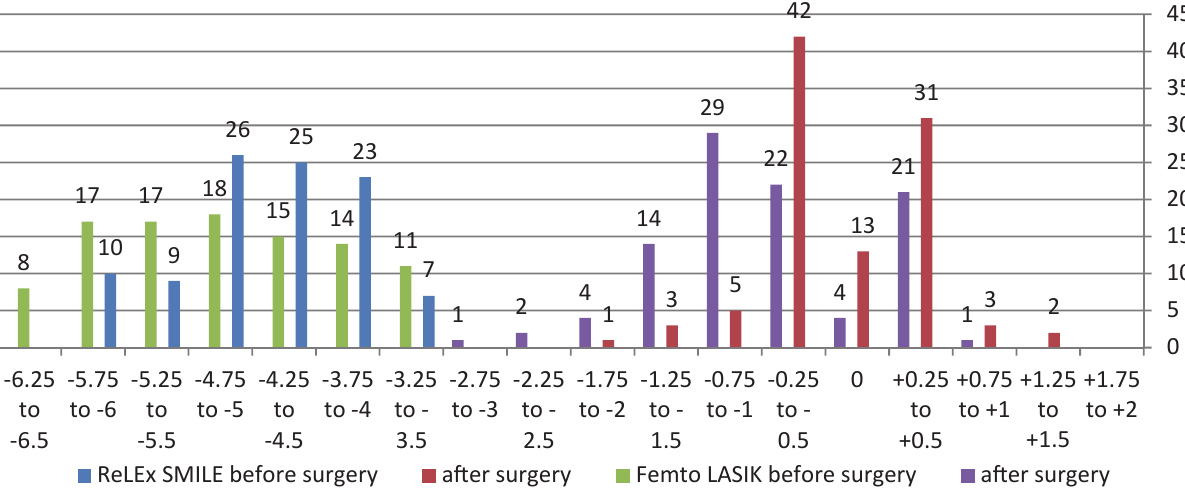
Fig. 1. Average of the presurgical and one- year postsurgical spherical equivalent of both eyes using femtoLASIK and ReLEx SMILE. X axis: representation of individual dioptric range. Y axis: number of eyes 1